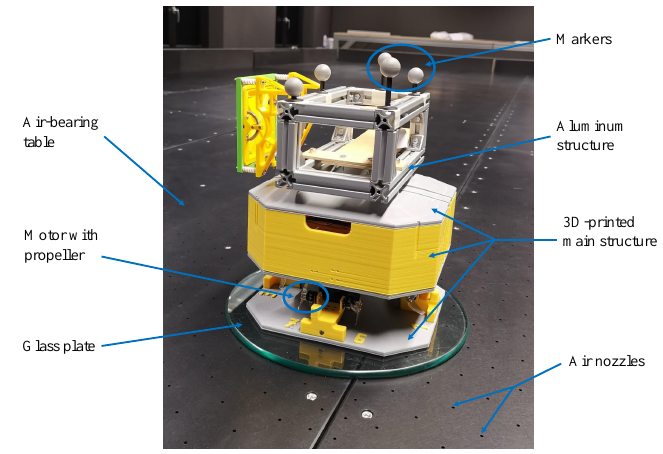
Figure 5. The mockup with a glass plate on the air-bearing